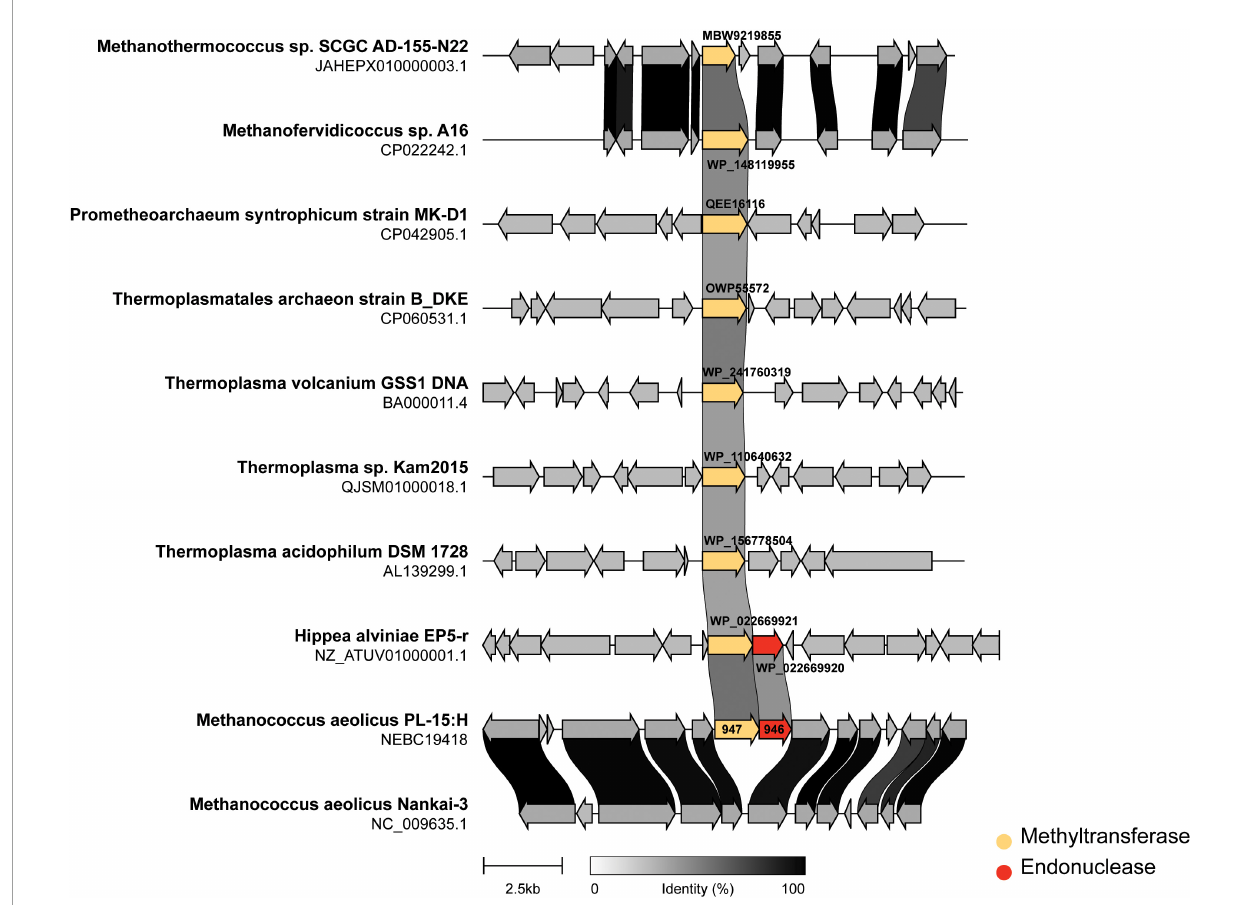
FIGURE6 Genomic neighborhoods of M. Mae III homologs across representative archaea. The m6A DNA methylase (M. Mae III) of M. aeolicus PL-15:H was used as a query sequence for a BLAST search taxonomically limited to archaea (taxid:2,157) at NCBI. Eight genomes from cultured archaea and one bacterium containing matching sequences to M. Mae III with an e -value of less than 10 - 30 were selected for genome neighborhood analysis. Sub genomic sequences surrounding the M. Mae III homologs were manually obtained by computationally extracting 7.5 kb of sequence, plus annotations, upstream and downstream of the methyltransferase encoding sequence. The resulting gene clusters were aligned and rendered using “clinker” gene diagramming software (Gilchrist and Chooi, 2020) with the methyltransferase colored yellow and endonuclease colored in red. The degree of amino acid identity among coding sequences are indicated by grayscale links connecting homologous